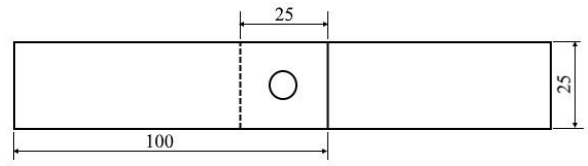
Table 1: Chemical composition (wt.%) of AA 6061-T6 aluminium alloy Si Fe Cu Mn Mg Cr Zn Ti Al 0.8 0.68 0.227 0.134 1.16 0.347 0.059 0.056